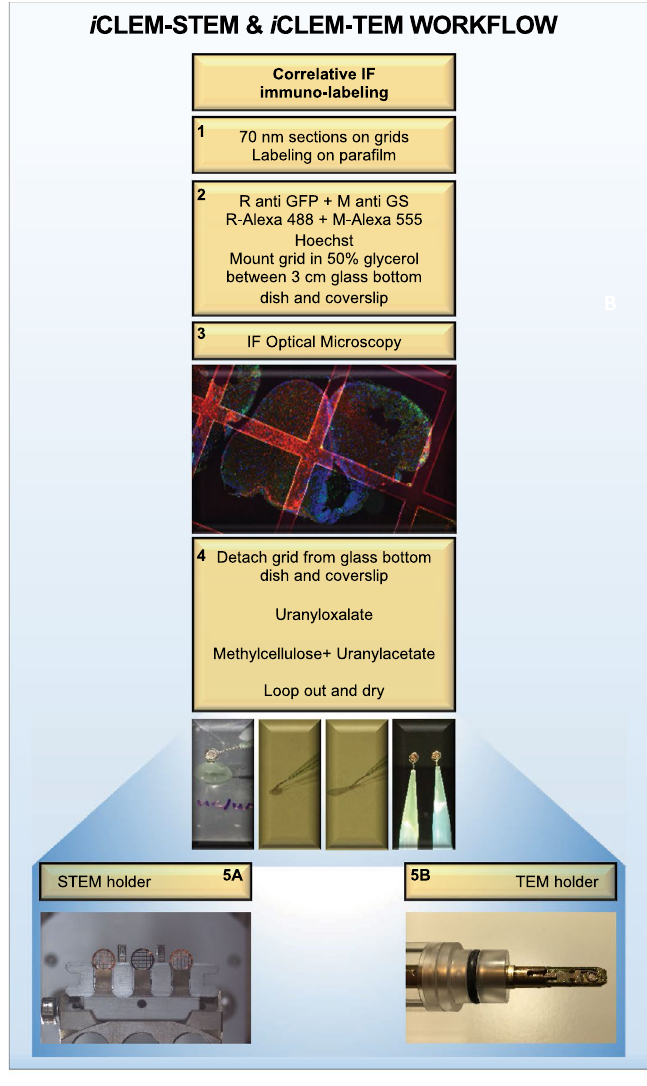
Figure 4. i CLEM-STEM and i CLEM-TEM workflow. Workflow of major tissue processing steps (1–5) common to i CLEM-STEM and i CLEM-TEM following Tokuyasu sample preparation. Once grids are looped out and dried for EM imaging, grids are placed on either a STEM holder (step—5A) or TEM holder (step—5B). Note that for STEM imaging, a specialized STEM holder for grids compatible with SEM in addition to a bottom detector positioned below the sample is required. Importantly, STEM samples are congruent with TEM samples and can be imaged sequentially if it is desirable to visualize the same sample at both resolutions. IF